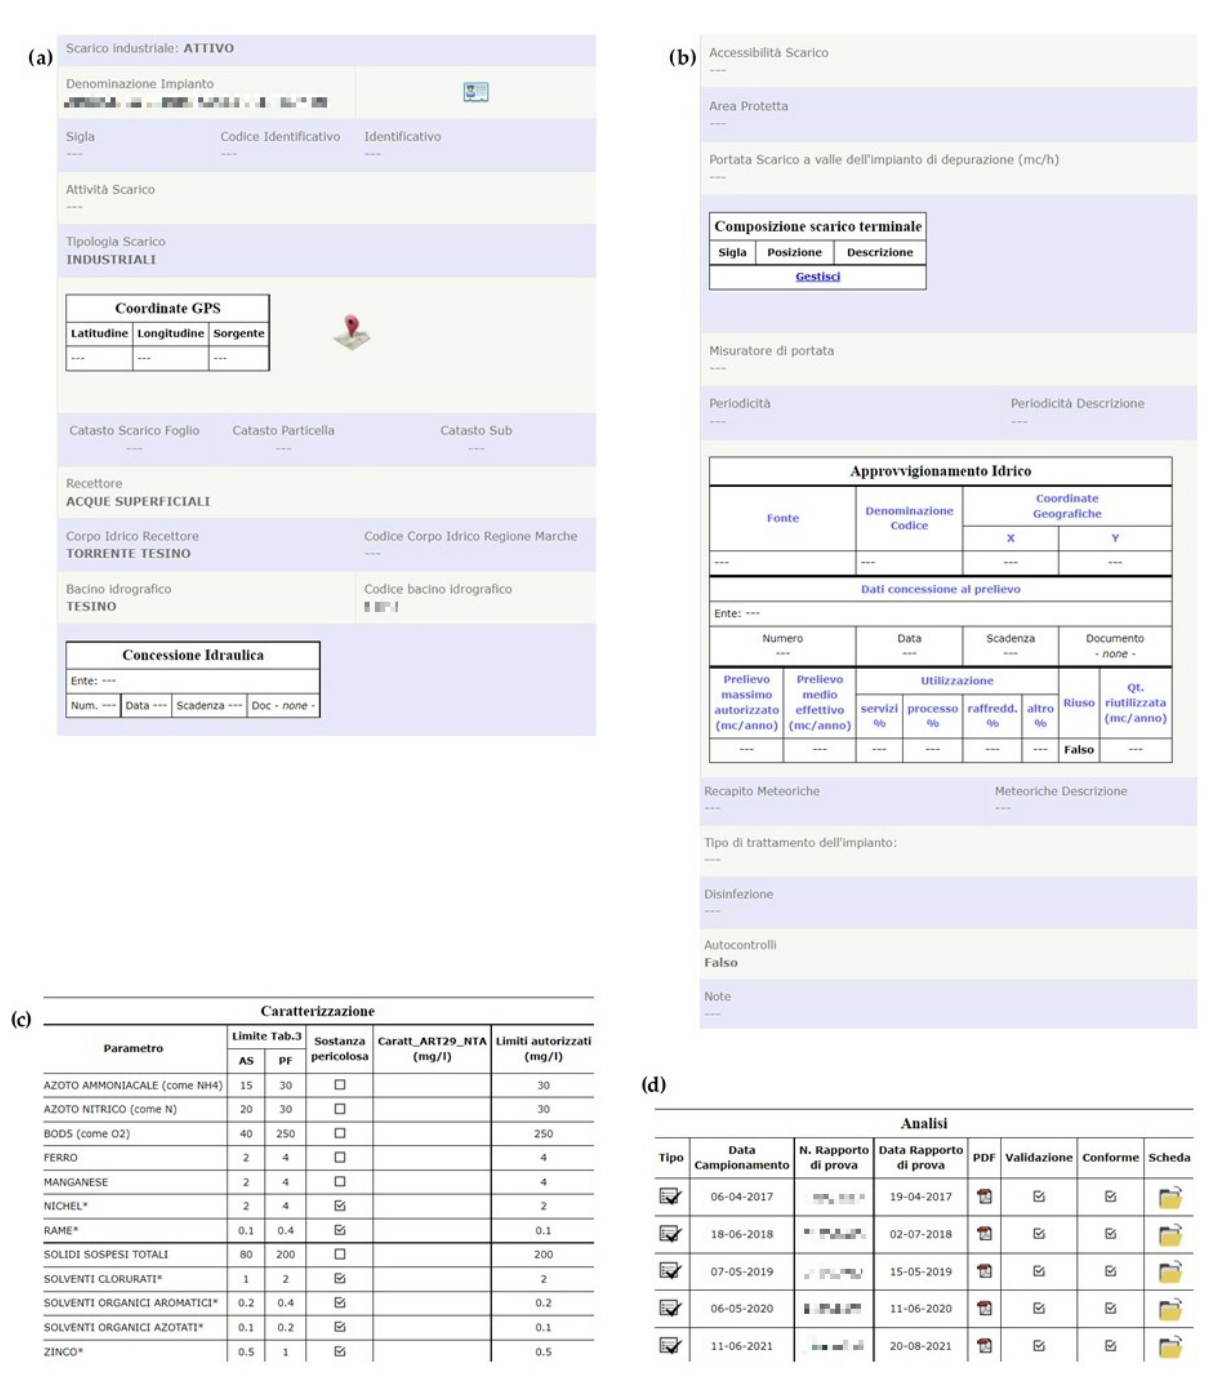
Figure 4. Example of the industrial wastewater subsection. ( a ) General information on a discharge point of an installation and the related receptor; ( b ) Technical specifications of the discharge; ( c ) Authorized emission limits; ( d ) List of the analytical checks carried out.